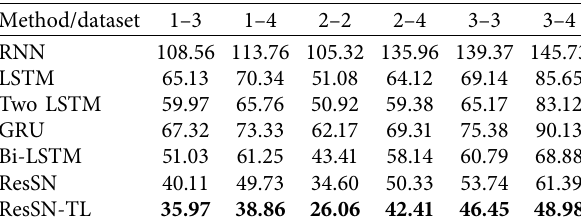
Table 3: RMSE for different methods on RUL prediction.